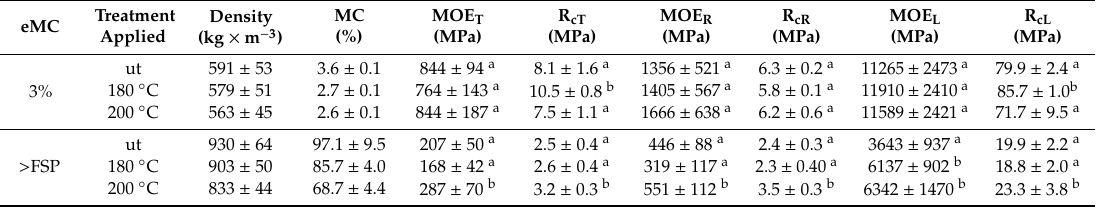
Table 1. Density, real moisture content (MC), modulus of elasticity (MOE) and relative /